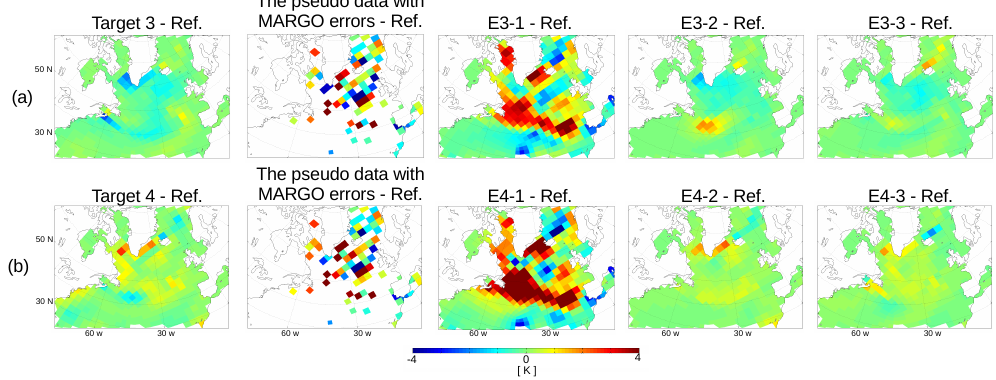
Fig. 7. Anomalies of the sea-surface temperature compared to the reference state in Target 3, the pseudo-data with the MARGO errors, E3-1, E3-2, and E3-3 (a) , and Target 4, the pseudo-data, E4-1, E4-2, and E4-3 (b)